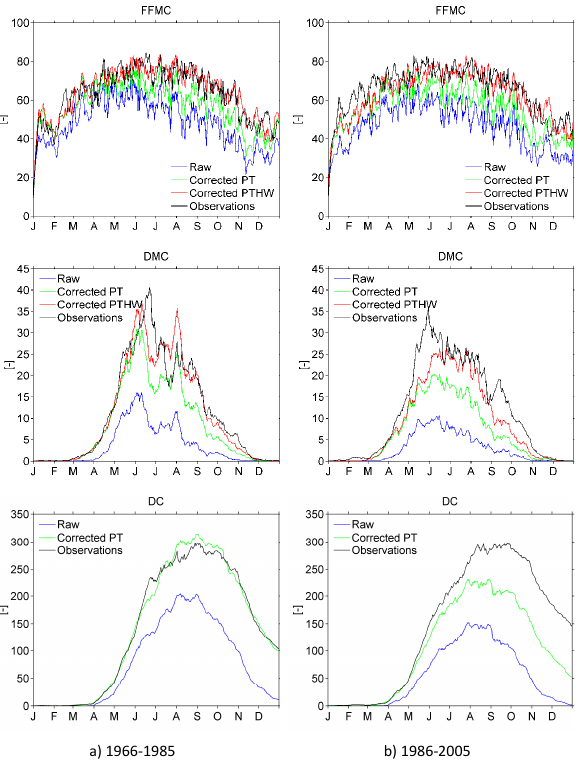
Figure 7. Seasonal variation of BUI, ISI and FWI index at the Edsbyn station (see Fig. 1). Comparison of values based on ob- servations (black line), raw output from climate model (blue line), RCA3-E5r3-A1B, corrected P (precipitation) and T (temperature) uncorrected (raw) RH (relative humidity) and W (wind speed) (green line) and corrected P (precipitation), T (temperature), RH (relative humidity) and W (wind speed) (red line) for period (a) 1966–1985 (calibration) and (b) 1986–2005